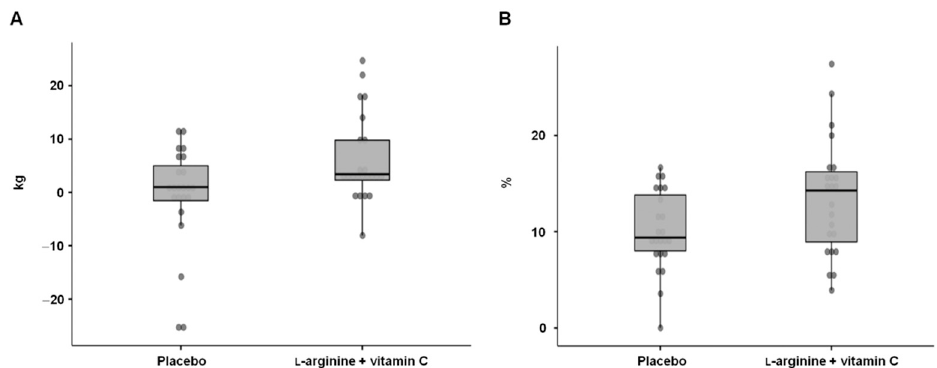
Figure 4. Changes from baseline to day 28 in ( A ) handgrip strength and ( B ) flow-mediated dilation in the two intervention groups. in the two intervention